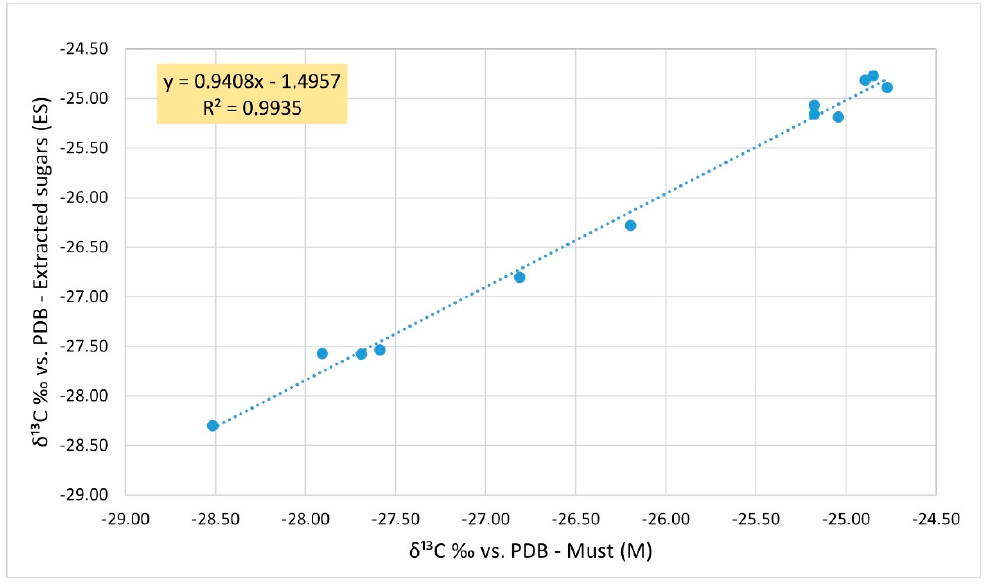
Figure 3. Relation between δ ¹³C values obtained from the analysis of must (M) samples with the corre- sponding extracted sugars (ES) samples, considering all the samples collected in the four study sites.